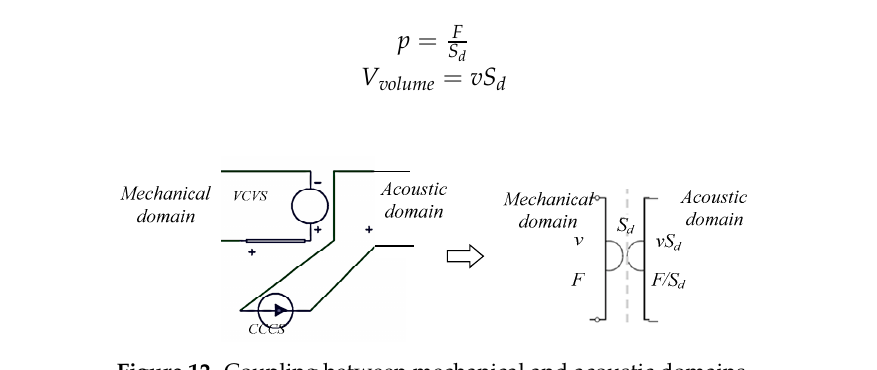
Figure 12. Coupling between mechanical and acoustic domains.